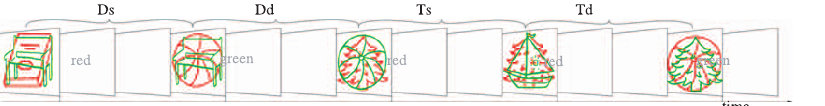
Figure 3. An example sequence of stimuli of Experiment 3. A trial begins with the display of the stimulus compound which is replaced by the color cue after a button press by the subjects. The fixation cross and the mask are omitted in the shown sequence for clarity.